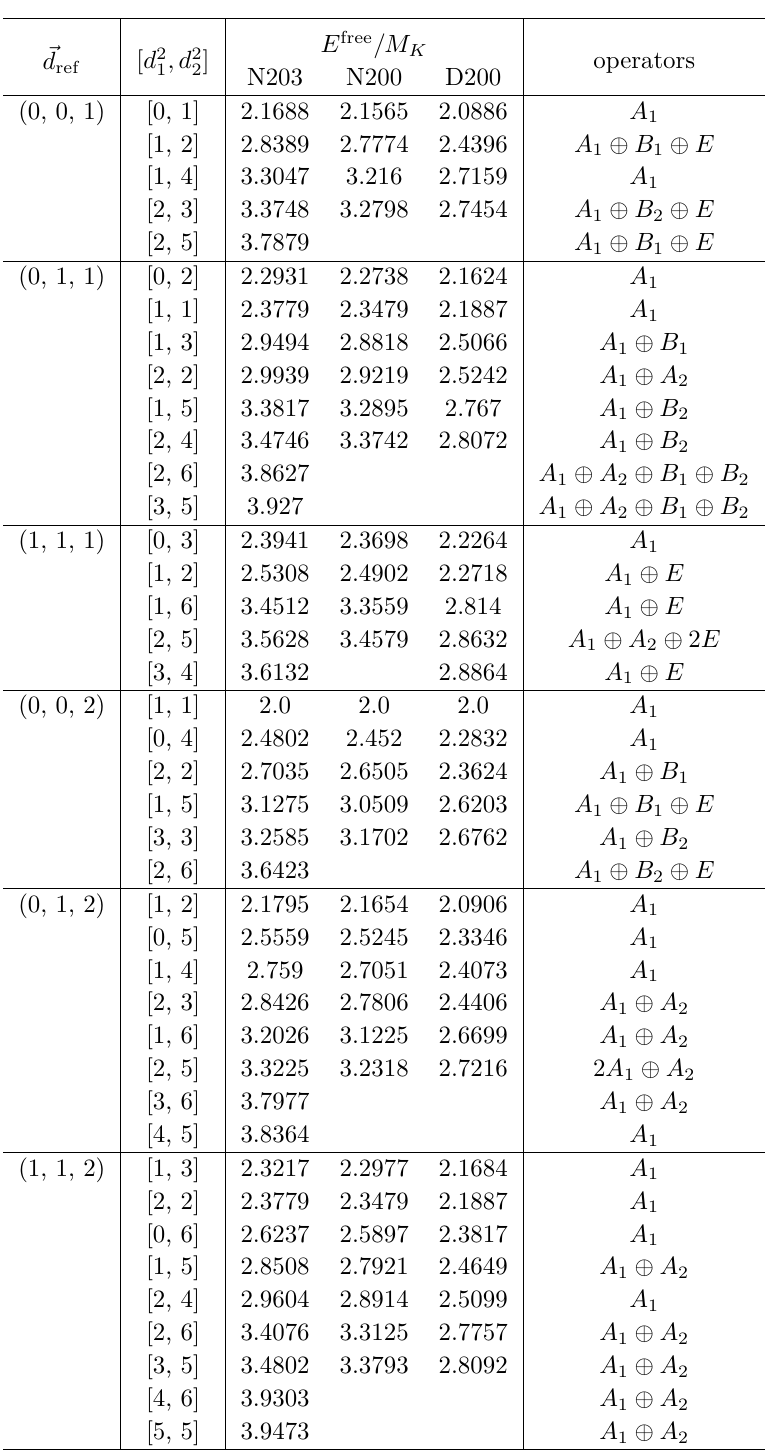
Table 30. Same as table 21 except for the two-kaon operators with 1 ≤ ~d 2